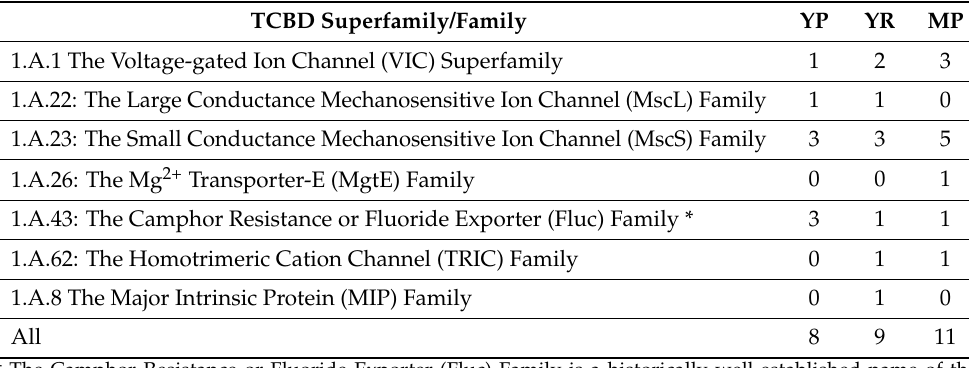
Table 5. Alpha-type channels in the studied genomes.